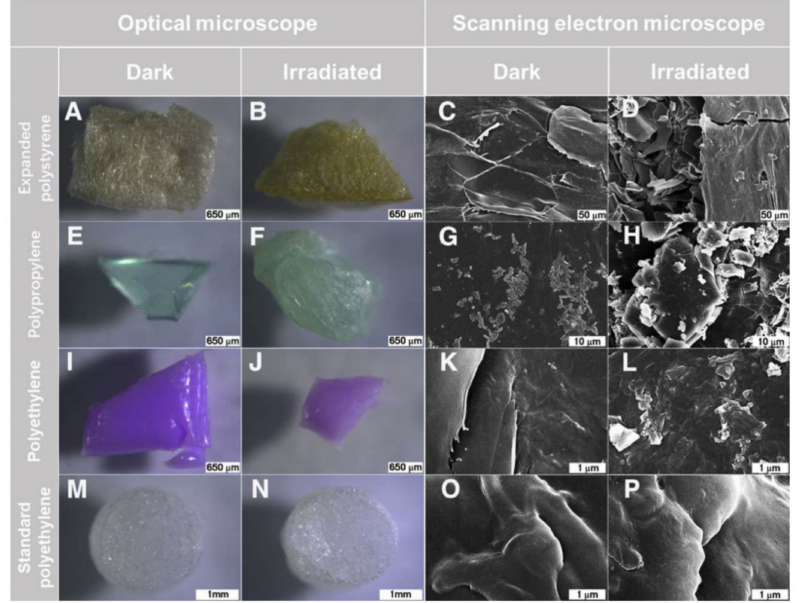
Figure 2. Pictures of investigated microparticles (L. Zhu et al. (2020)). Copyright